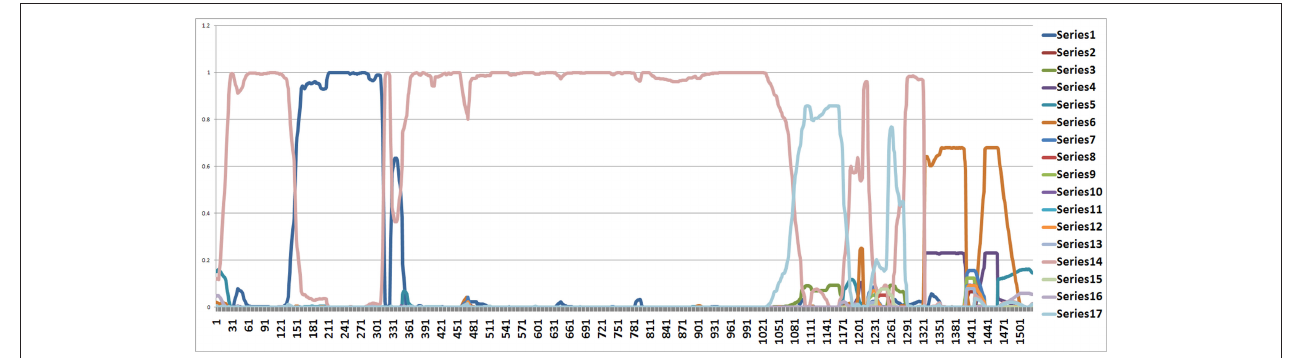
Figure 2 | The figure shows an estimated probability of each tree topology along each site computed using the software from Webb et al. (2009). The label of “Series i ” for i = 1, … ,17 in the figure represents each different tree